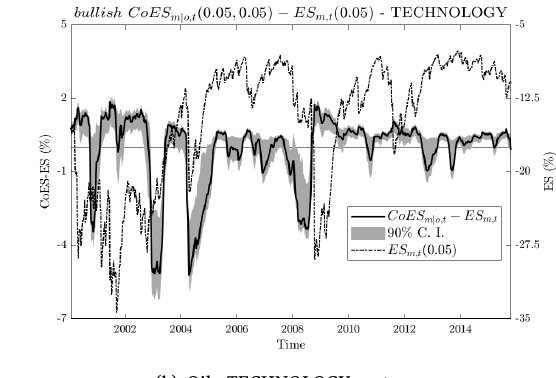
(i) Oil - UTILITIES sector (j) Oil - FINANCIALS sector